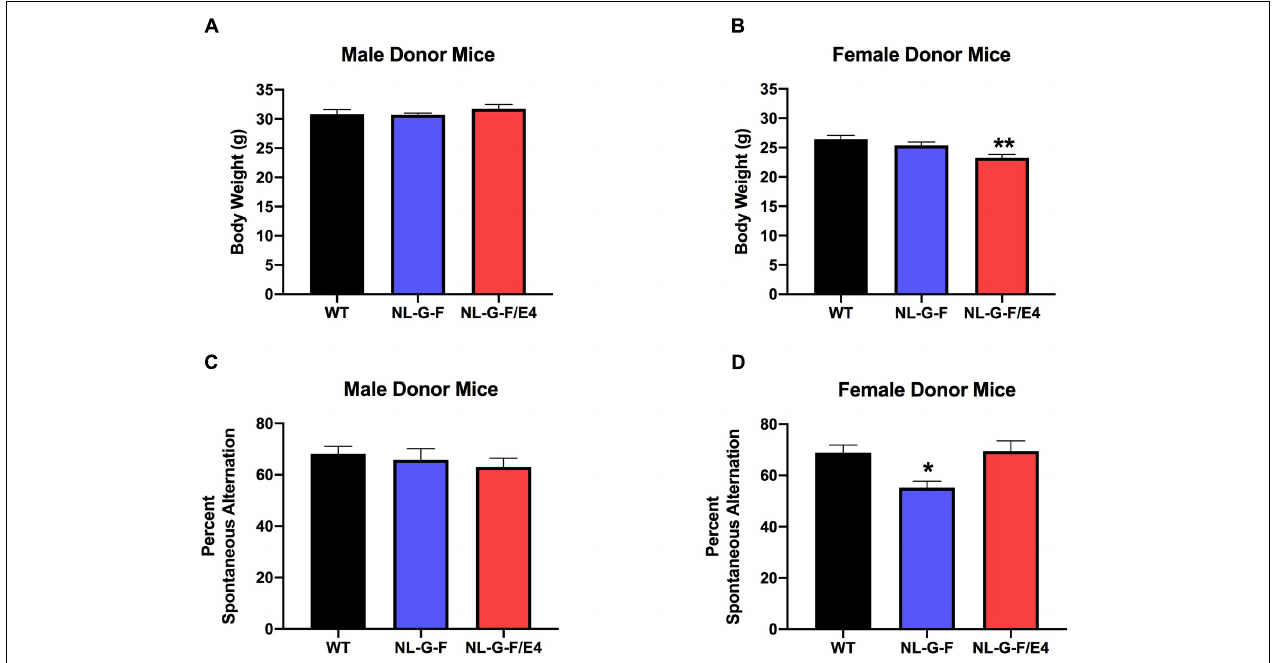
FIGURE 2 | (A) There was no effect of genotype on body weights of male donor mice. (B) There was an effect of genotype on body weights of female donor mice ( F (2,34) = 6.044, p = 0.0057). App NL − G − F / E4 females were lighter than WT females. ** p = 0.0032, Dunnett’s. (C) There was no effect of genotype on spontaneous alternation in male donor mice. (D) There was an effect of genotype on spontaneous alternation in female donor mice ( F (2,40) = 6.136, p = 0.0047). The percent spontaneous alternation was lower in App NL − G − F than WT female donor mice. * p = 0.0163,